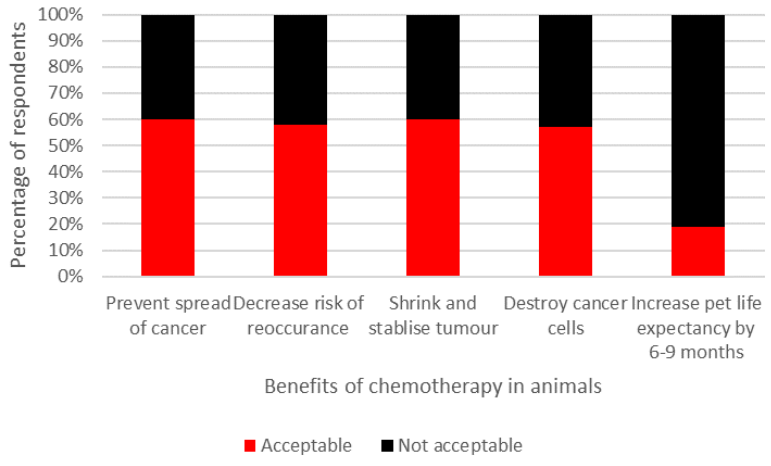
Figure 3. Acceptability of beneficial effects associated with chemotherapy treatment in dogs and cats.